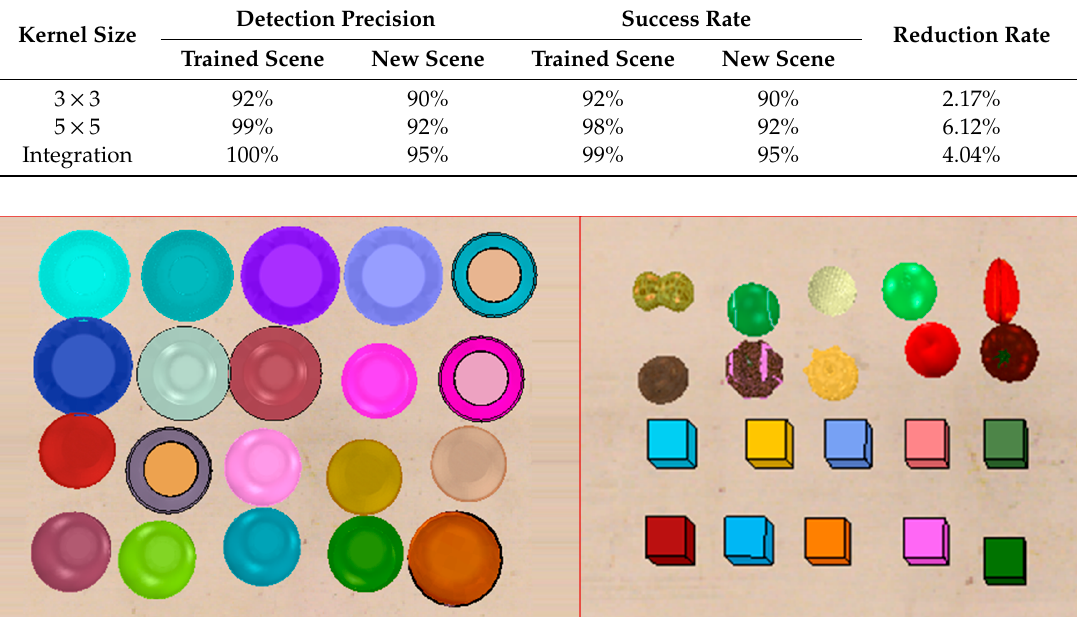
Figure 8. Novel objects and containers in the testing phase.